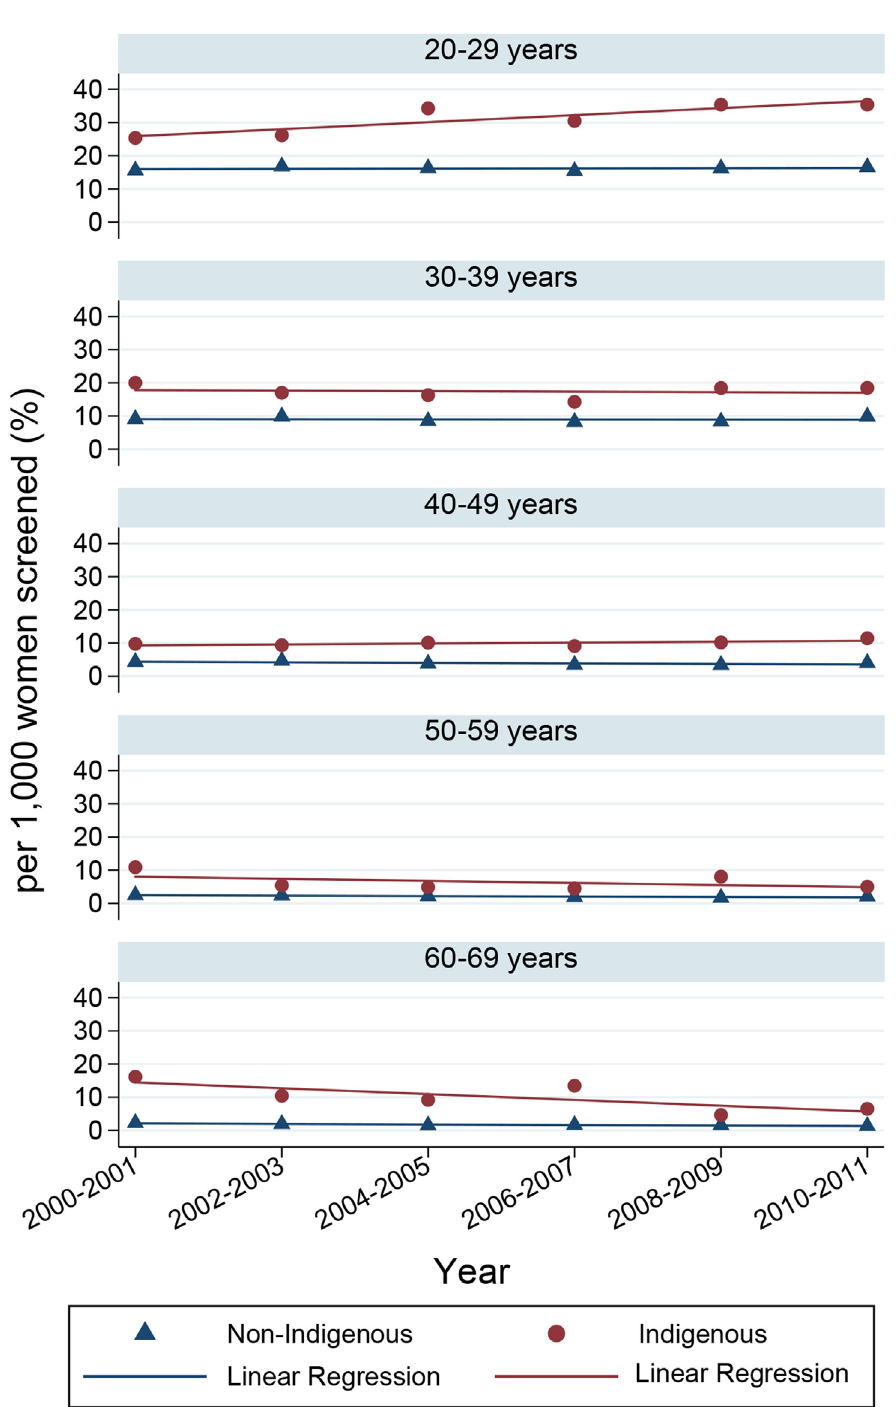
Fig 1. Prevalence of histologically confirmed high-grade abnormalities per 1000 women screened, by age-group and Indigenous status, 2000 – 2011.